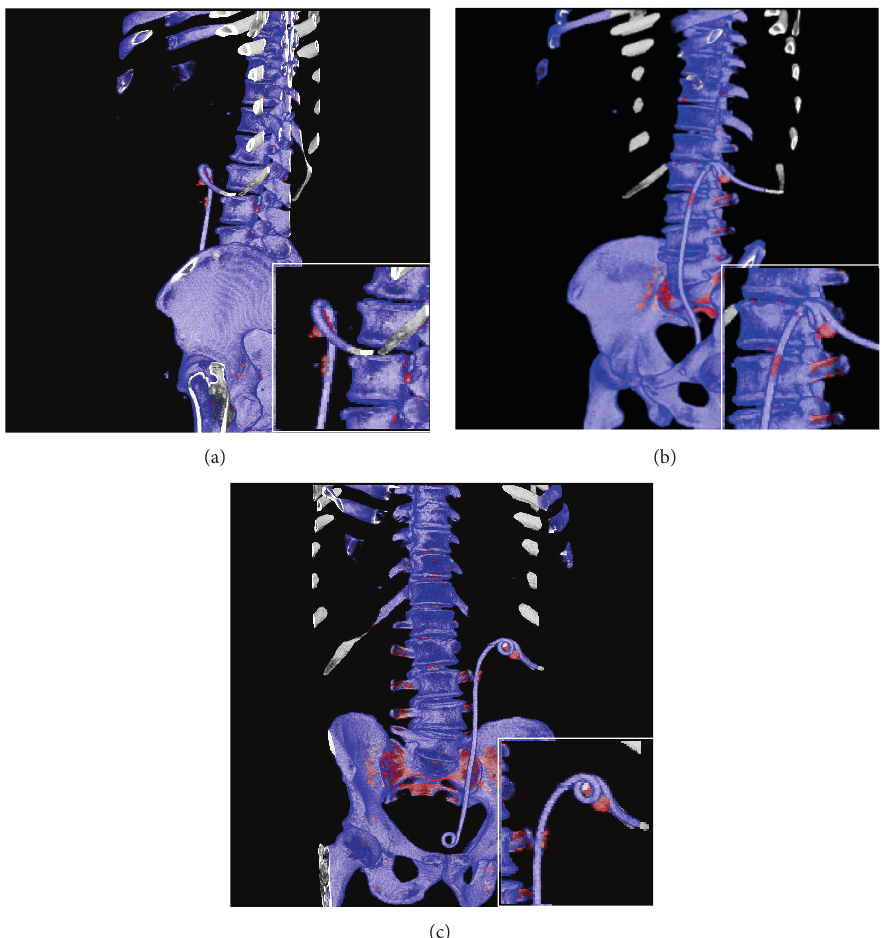
Figure 2: Three-dimensional dual-energy computed tomography (3D DECT) images, viewed from different angles ((a), (b), and (c)) to identify the stone/stent boundary and assess the stone’s shape and